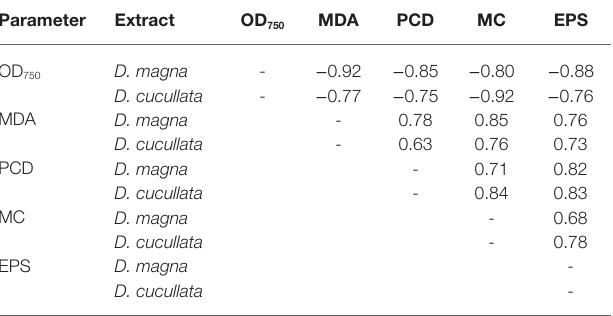
TABLE 1 | Spearman’s correlation coefficient ( Rs ) calculated between parameters measured in M. aeruginosa after 7 days of exposure to extracts of D. magna and D. cucullata